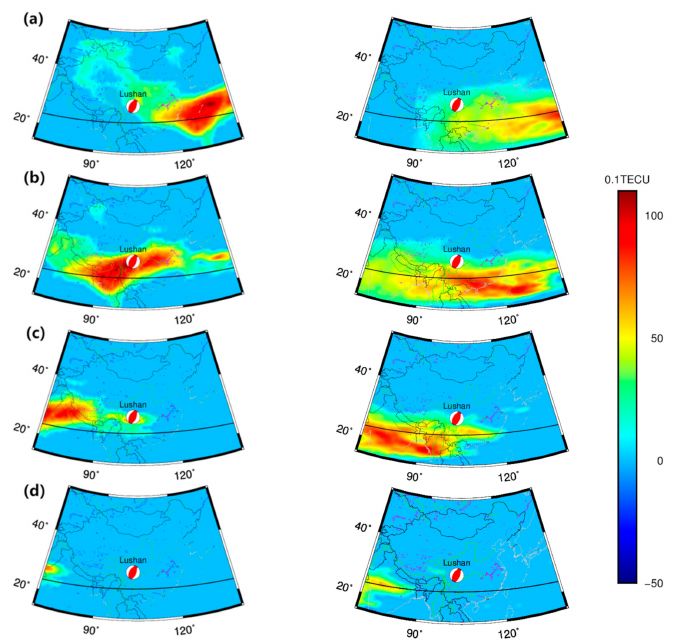
Figure 6. Spatial distribution of ionospheric anomalies 14th day (left) and 19th day (right) prior to the Lushan earthquake based on regional ionosphere maps (RIM), in which the focal sphere represents the epicenter, and the black curves show the bounds of equatorial anomaly zone. ( a ) 00:00 UTC; ( b ) 02:00 UTC; ( c ) 04:00 UTC; and ( d ) 06:00